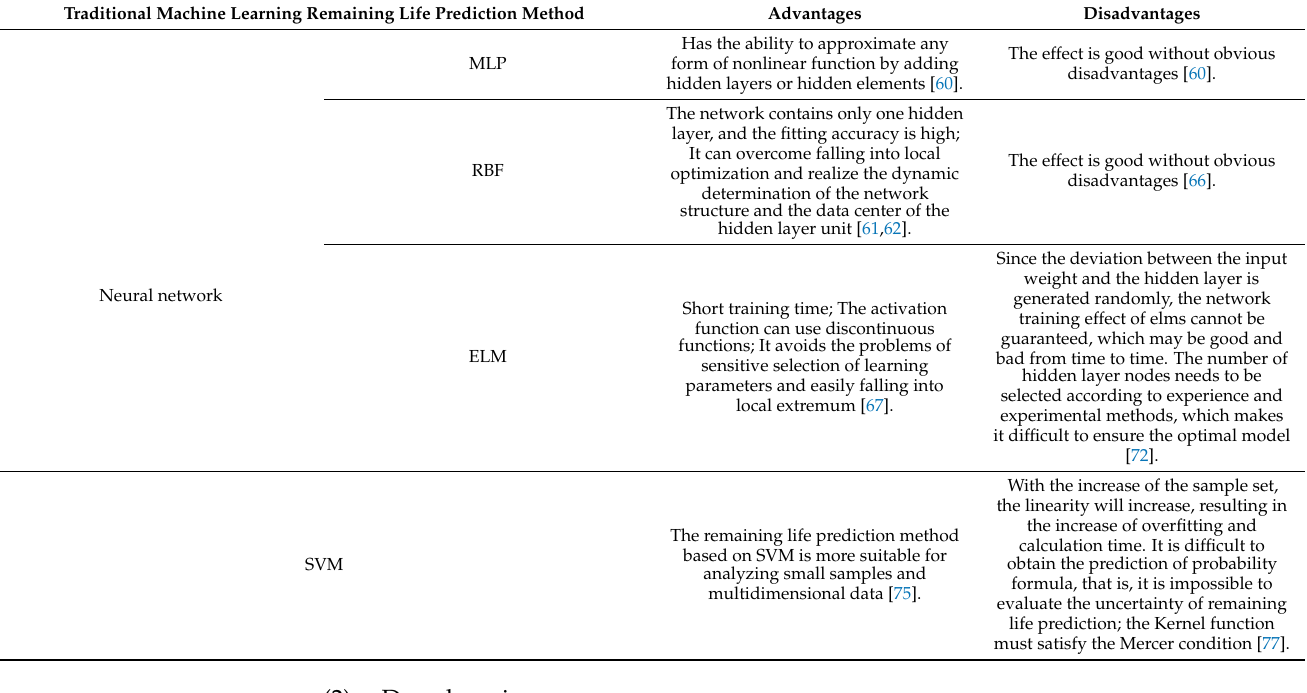
Classification and characteristics of traditional machine learning remaining life prediction